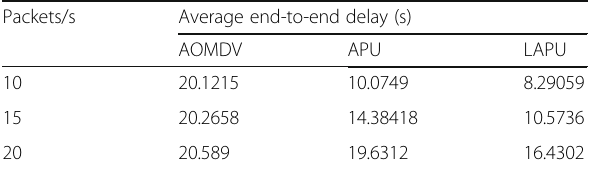
Table 4 Routing overhead vs. data rates